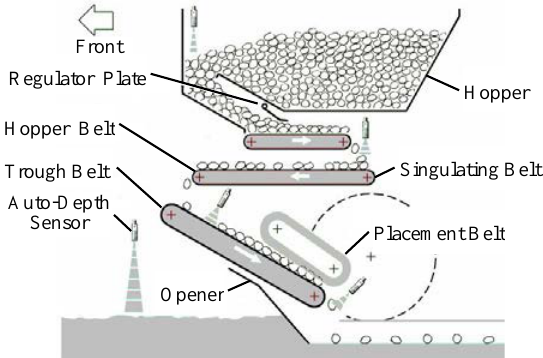
Figure 7. Moving-belt-type seed metering device used in commercial planter.